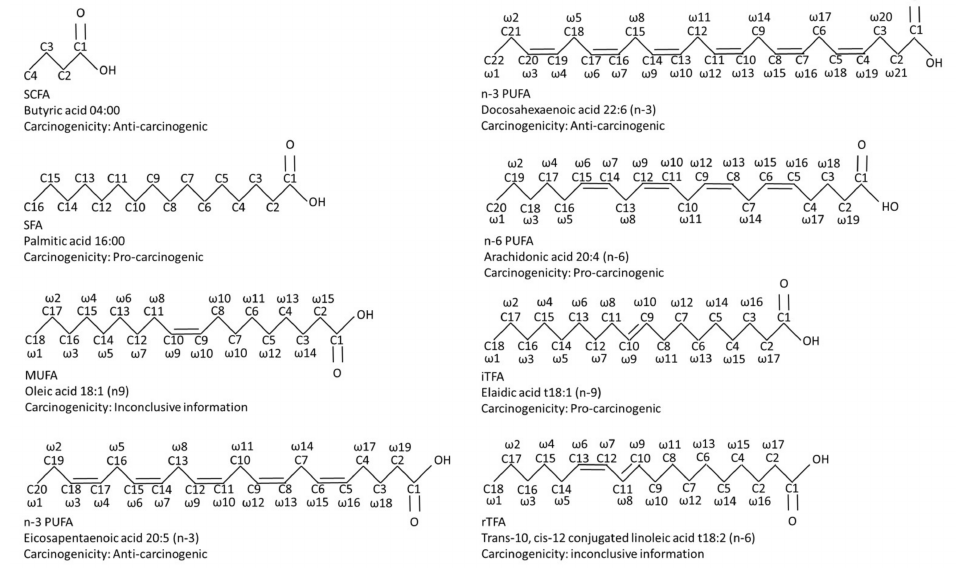
Figure 1. A comparative diagram of the chemical structures of the most investigated fatty acids, including their pro-tumor and anti-carcinogenic properties. Abbreviations: iTFA, industrial trans- fatty acid; MUFA, mono-unsaturated fatty acid; n -3 PUFA, omega-3 poly-unsaturated fatty acid; n -6 PUFA, omega-6 poly-unsaturated fatty acid; rTFA, ruminant trans-fatty acid; SCFA, short-chain fatty acid; SFA, saturated fatty